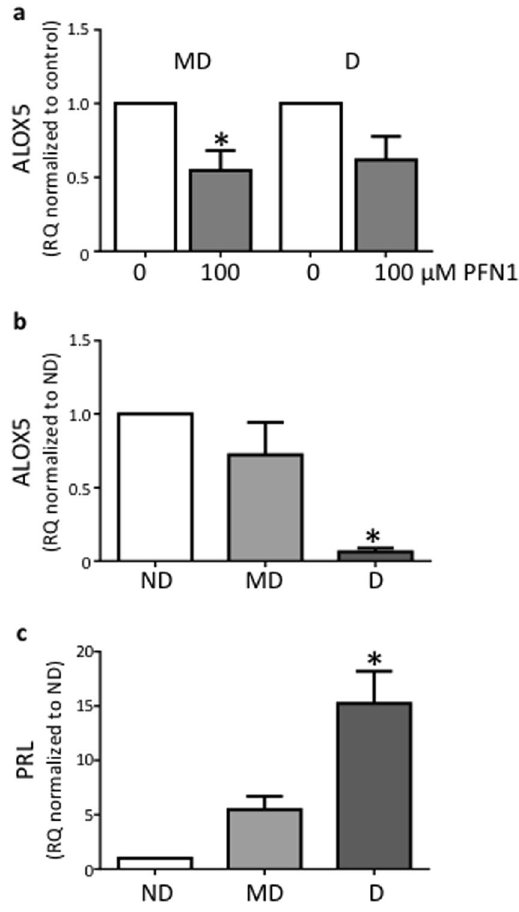
Figure 2. Exogenous profilin 1 decreased HESC ALOX5 expression. ( a ) PFN1 significantly decreased ALOX5 mRNA in minimally decidualized (MD) HESC (decidualized for 2 days, do not secrete detectable PRL; n = 4–6/ group) but had no significant effect on decidualized (D) HESC (decidualized for 10–12 days, secrete PRL). ( b ) ALOX5 mRNA expression declined during in vitro HESC decidualization (n = 4–10/group). ( c ) Prolactin confirmation of decidualization (n = 4–10/group). mRNA expression was determined by semi-quantitative PCR normalized to 18S. Data are mean ± SEM, * p < 0.05, significant difference from control. a: paired t-test; b,c: one-way